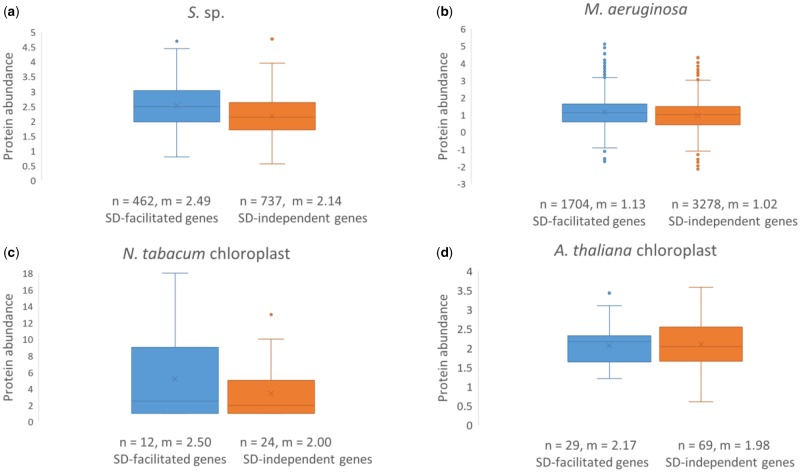
—Contrasts in protein abundances between SD-facilitated genes (SD/anti-SD pair ≥4 nt and SD within optimal DtoStart) and SD-independent genes. Protein abundances in Cyanobacteria (a, b) were measured by log(ppm) and retrieved from PaxDb database, in N. tabacum chloroplast (c) were measured by number of unique peptides and retrieved from Wu and Yan (2018), and in A. thaliana chloroplast (d) were measured by log(total spectral counts) and retrieved from Ferro et al. (2010) curated as plastid proteins by Zybailov et al. (2008). All genes are non-pseudo with protein abundance >0. For each gene set, the number of genes (n) and median (m) is denoted under the boxplots.